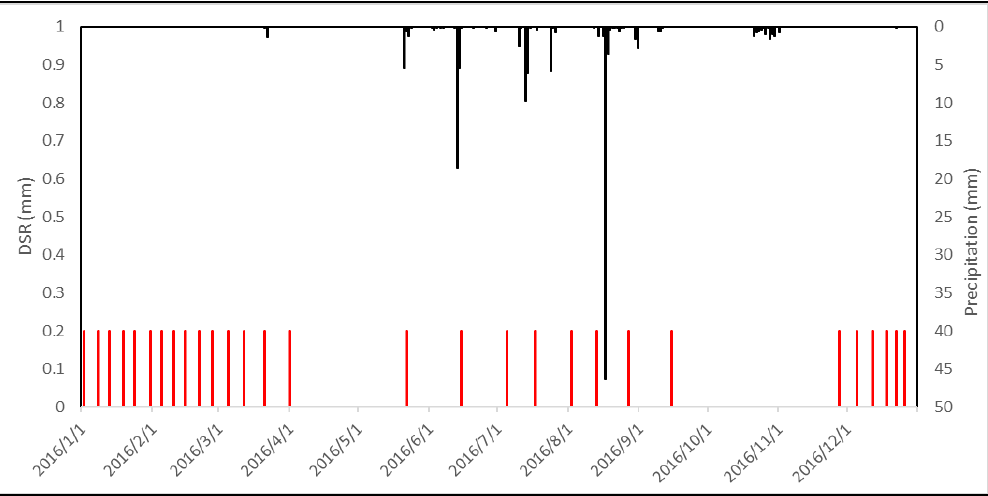
Figure 7. Relationship between precipitation and DSR in 2016 .